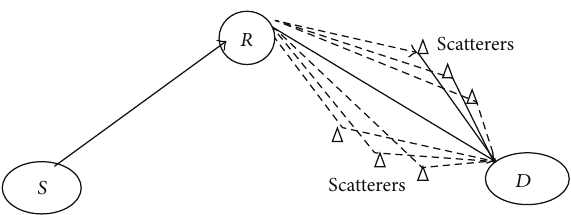
Figure 1: Heterogeneous compound channel formation due to envi- ronmental (scattering) variations in each